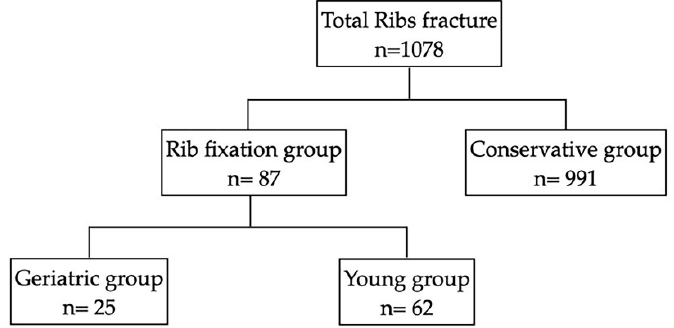
Figure 2. The study diagram of the enrollment of rib fracture patients. Males accounted for 71.3% ( n = 62) of the participants, and 32.2% ( n = 28) were obese. The overall median age was 56 years. The causes of injury included motor vehicle collisions (66.7%, n = 58), falls (31.0%, n = 27), and crushing (2.3%, n = 2). The median scores of ISS, NISS, and TRISS were 20, 24, and 0.94, respectively. A total of 12.6% ( n = 11) of patients had bilateral rib fractures. The median number of fractured ribs was 6, and 49 patients had flail segment fracture at arrival. There were 25 geriatric patients (28.7%), with a median age of 70 years old. Compared with the non-geriatric group, the geriatric patients presented with higher chest AIS ( p = 0.037). The geriatric patients also had higher rates of rib fracture with flail segments than the non-geriatric group (76% versus 48.4%, p = 0.031), which might be related to the osteoporosis of aging. RF fixation was also performed in some severe-head-injury patients, and 16.1% ( n = 14) of patients had a head AIS of